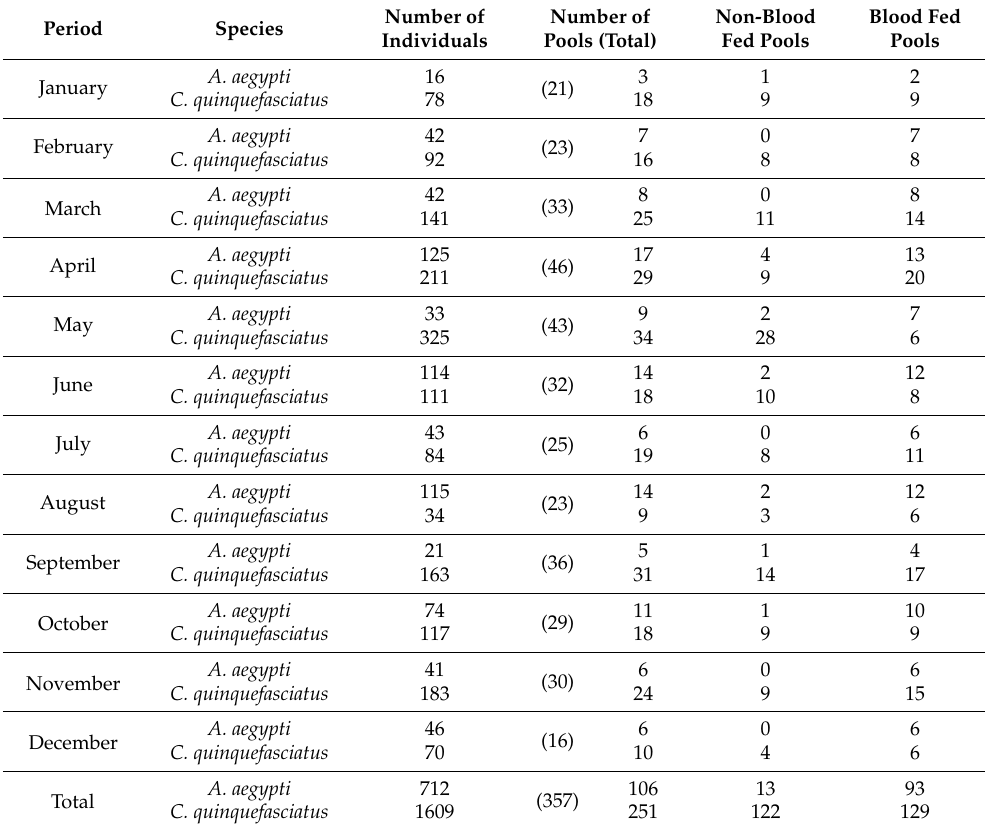
Table 2. Overview of specimens and blood-feeding status of mosquitoes sampled in health care units from the metropolitan area of Recife in 2018.